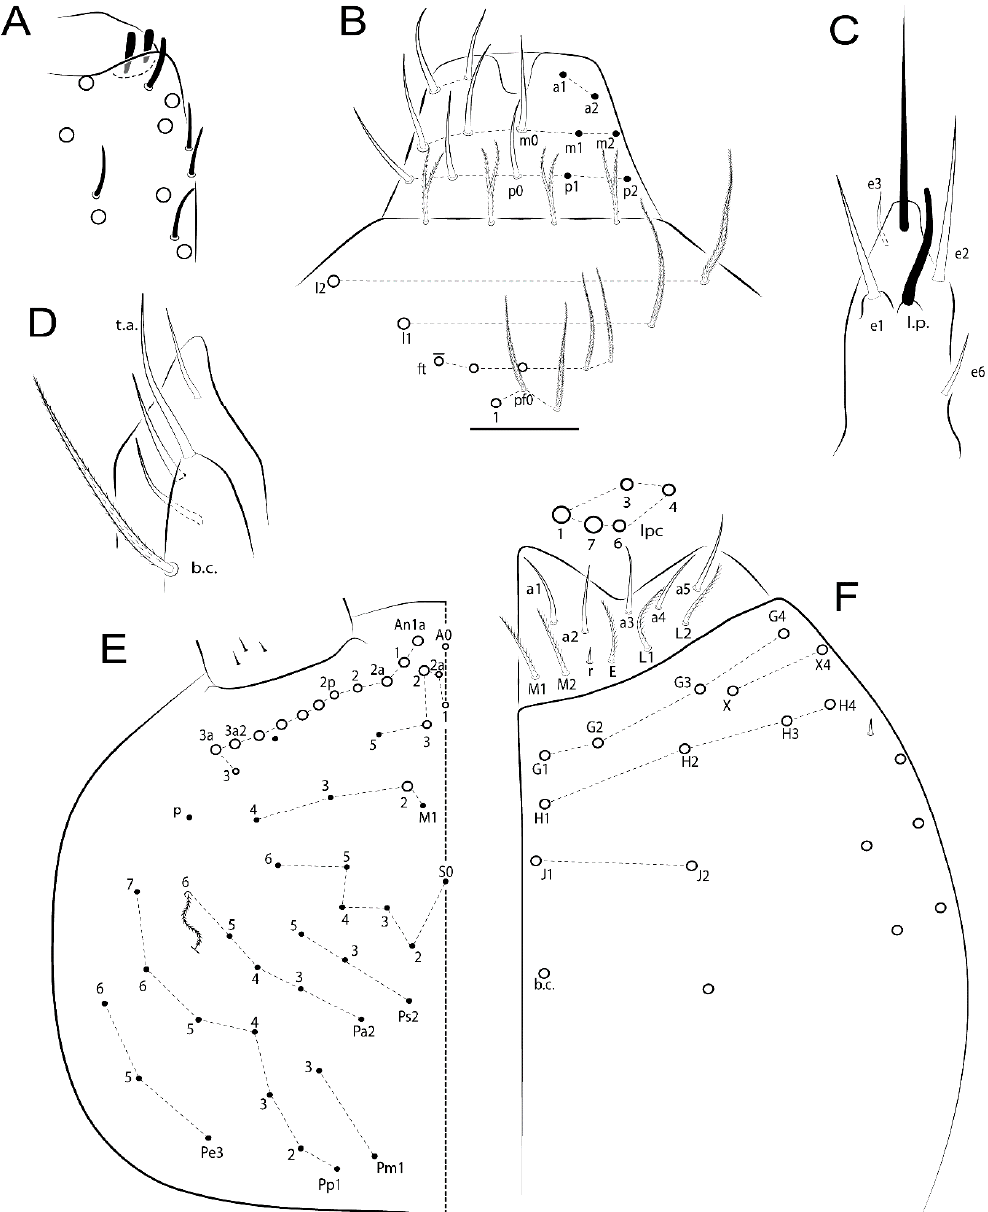
Figure 75. Pseudosinella phyllunguiculata sp. nov.: head. ( A ) Ant III apical organ (lateral view); ( B ) chaetotaxy of clypeus, prelabrum, and labrum; ( C ) labial papilla E; ( D ) maxillary palp and sublobal plate (left side); ( E ) head dorsal chaetotaxy (left side); ( F ) labial proximal chaetae; basomedian and basolateral labial fields; and complete postlabial chaetotaxy (right side).